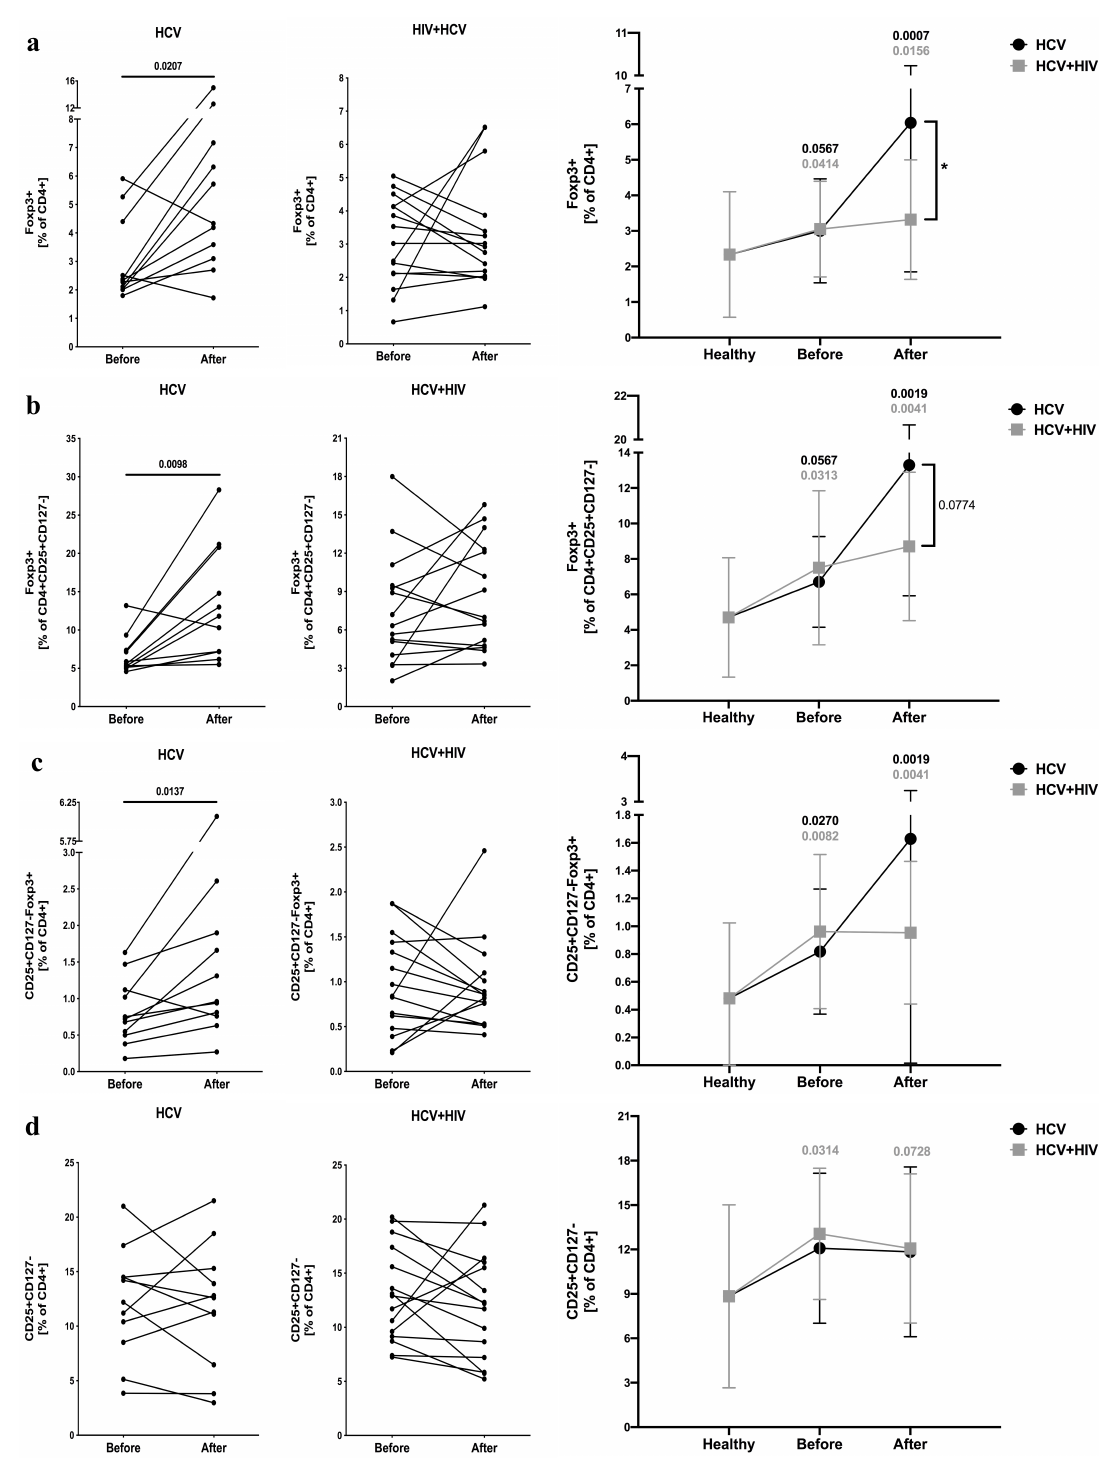
Figure 1. Frequencies of regulatory T cells in HCV-infected (left column) and HCV/HIV-coinfected (right column) patients in the course of anti-viral therapy. Data presenting the effects of therapy and differences between studied groups in the course of treatment in relation to healthy control subjects. Treg-related parameters included: Foxp3-positive cells within CD4 + ( a ) and CD4 + CD25 + CD127 − lymphocytes ( b ), frequency of CD25 + CD127 − Foxp3 + ( c ) and CD25 + CD127 − ( d ) in pool of CD4 + T